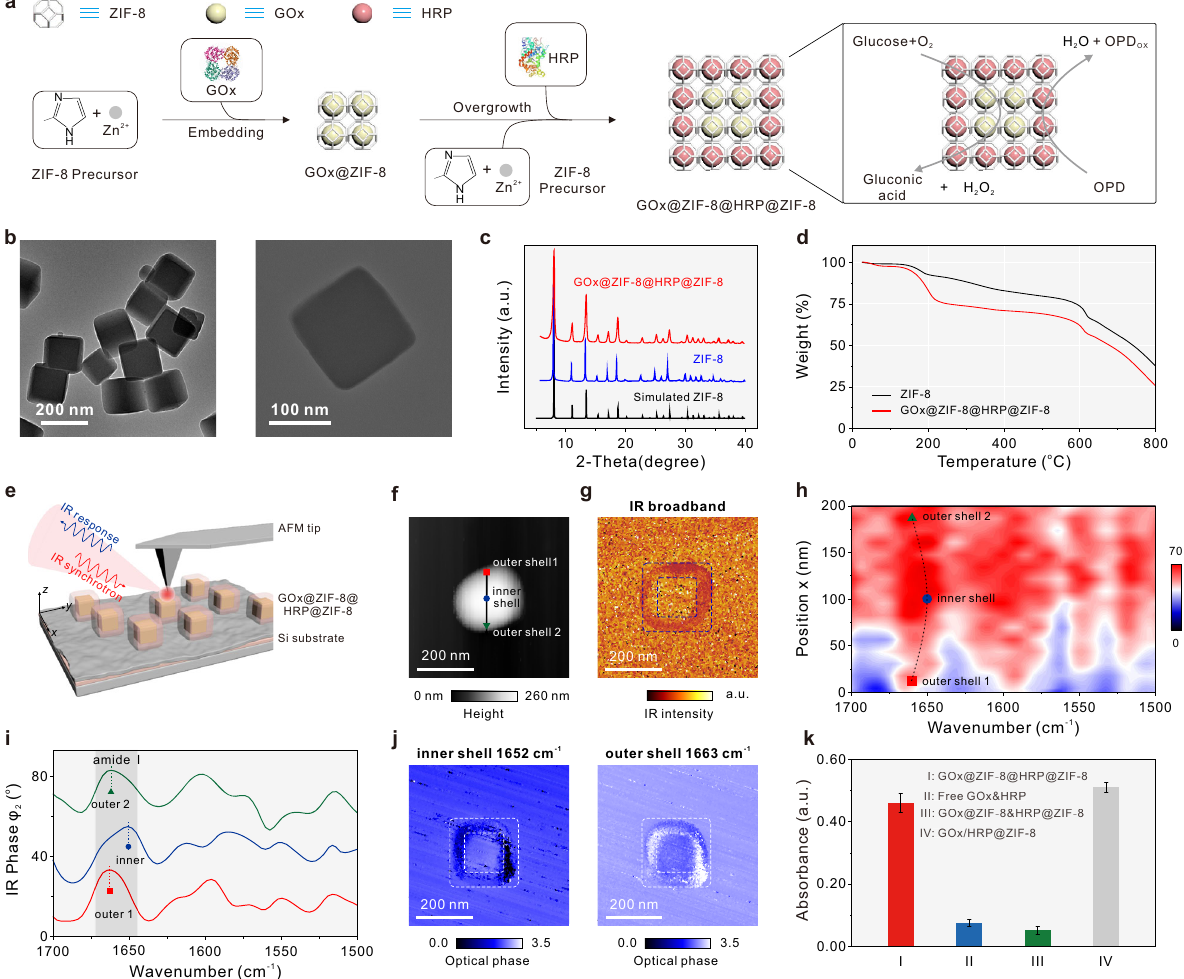
Fig. 1 Operation of GOx-HRP cascade in multi-shelled ZIF-8 MOFs. a Tandem biocatalytic reaction driven by compatible enzymes (GOx and HRP) encapsulated in multi-shelled ZIF-8. b TEM image of as-synthesized GOx@ZIF-8@HRP@ZIF-8. c XRD pattern simulated from CIF fi le of ZIF-8 (black), XRD patterns of synthesized ZIF-8 (blue), and GOx@ZIF-8@HRP@ZIF-8 (red), respectively. d TGA curves of synthesized ZIF-8@ZIF-8 (black) and GOx@ZIF- 8@HRP@ZIF-8 (red), respectively. Nanoscale heterogeneity in GOx@ZIF-8@HRP@ZIF-8 by nano-FTIR analysis: e Setup employing a mid-infrared laser continuum source or a tunable quantum cascade laser (QCL) for tip illumination. AFM mapping simultaneously retrieves nanoscale morphology and nano- FTIR spectra. Simultaneously recorded f AFM topography image and g IR broadband image. h nano-FTIR line scan along the solid arrow marked in panel f with a step size of ~10 nm, and 18 spectra were recorded. i Representative nano-FTIR point spectra of the inner shell (inner) and outer shell (outer 1 and outer 2) of the particle, marked by respective colored symbols. j Infrared phase images recorded at inner-shell 1652 cm − 1 and outer-shell 1663 cm − 1 of an individual particle. k Catalytic ef fi ciencies in GOx@ZIF-8@HRP@ZIF-8, free GOx & HRP, GOx@ZIF-8 & HRP@ZIF-8, and GOx/HRP@ZIF-8 systems. In all experiments, the concentrations of GOx and HRP used were 4.71 and 14.4 μ g mL − 1 . The error bars represent standard deviation based on three